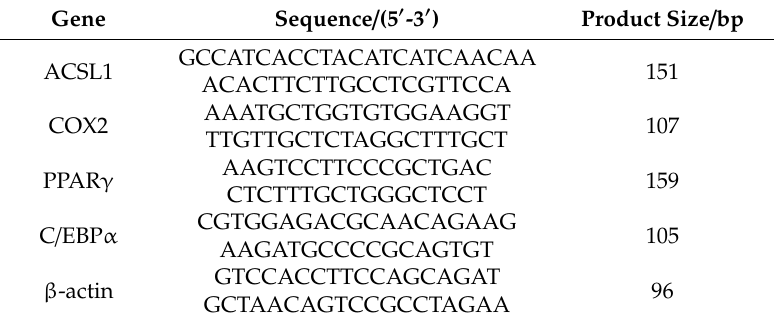
Table 2. Primers for quantitative real-time polymerase chain reaction. Gene Sequence / (5 (cid:48) -3 (cid:48)